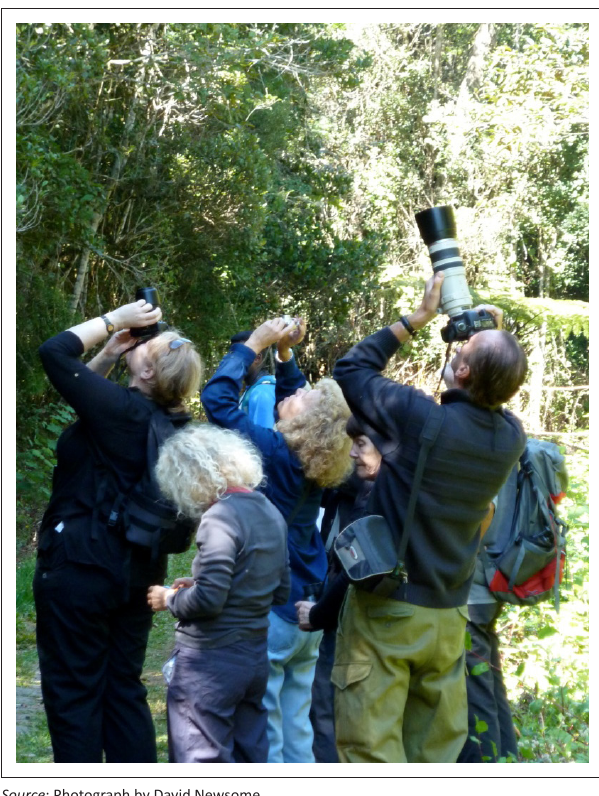
FIGURE 1: Small group of international tourists (niche tourism) viewing and photographing indri at Andasibe National